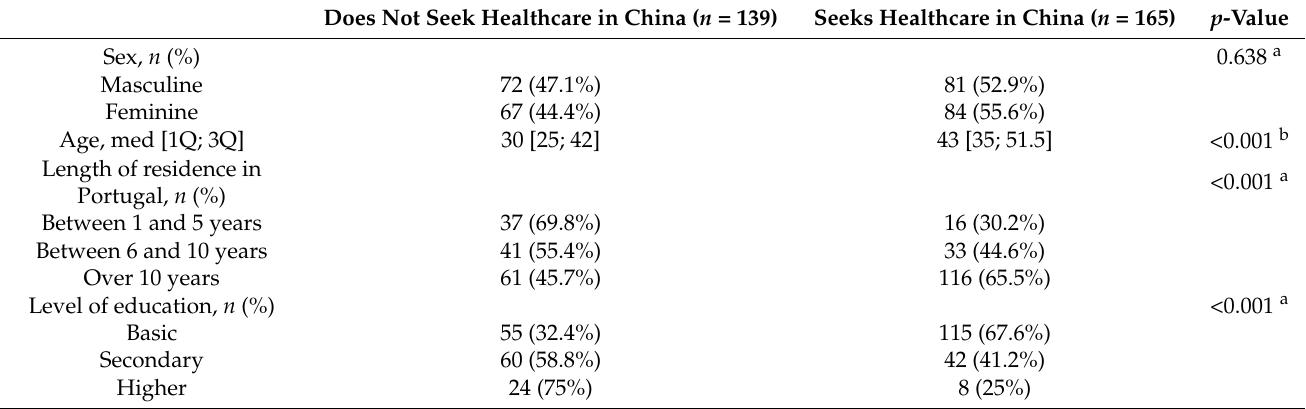
Table 6. Comparison of the variables sex, age, length of residence in Portugal and level of education according to the demand for healthcare in China ( n =